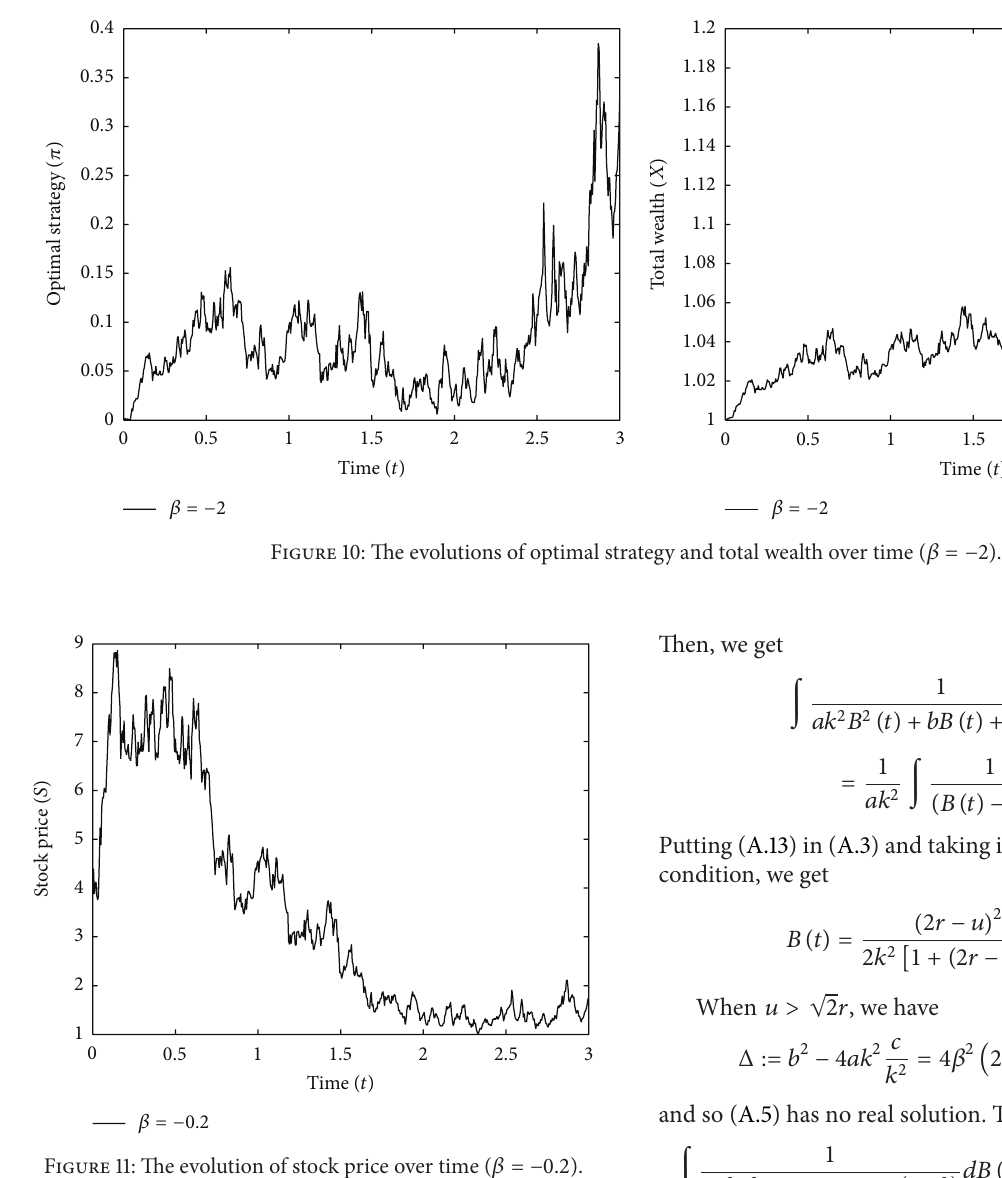
Figure 11: The evolution of stock price over time ( 𝛽 = −0.2